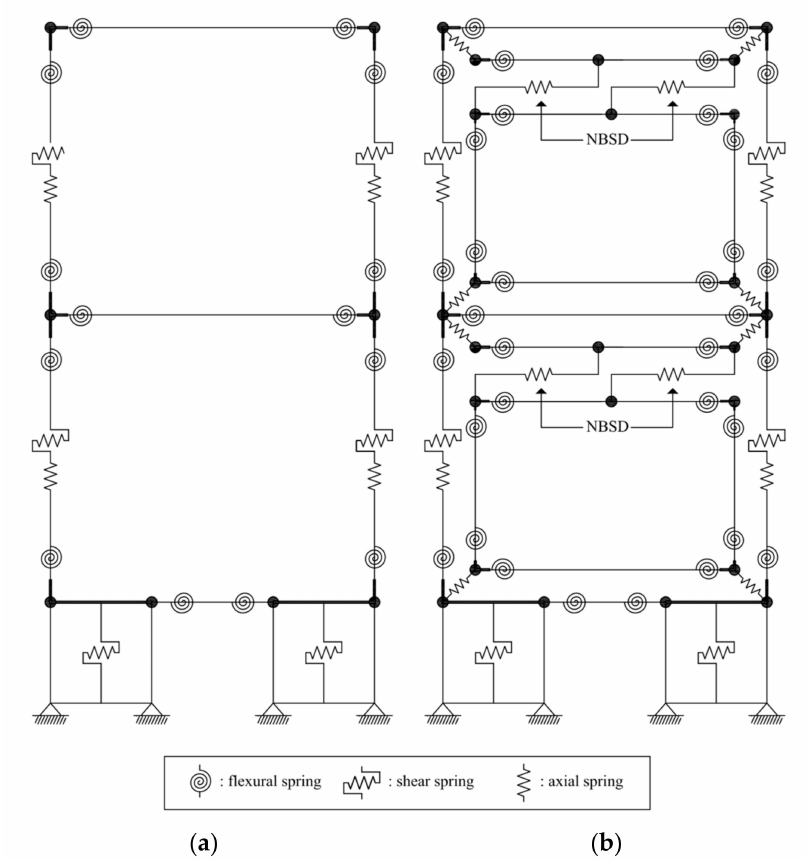
Figure 22. Nonlinear dynamic analysis models: ( a ) Existing frame with no reinforcement applied (PD-FR) and ( b ) frame retrofitted with NBSD-WSCS (PD-NBSD-WSCS).